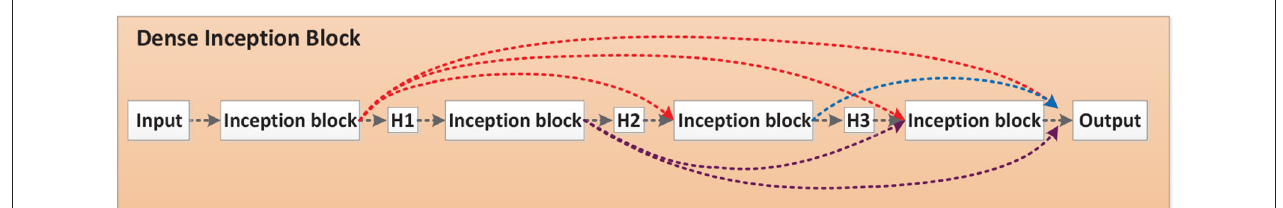
FIGURE 5 | Dense Inception block.